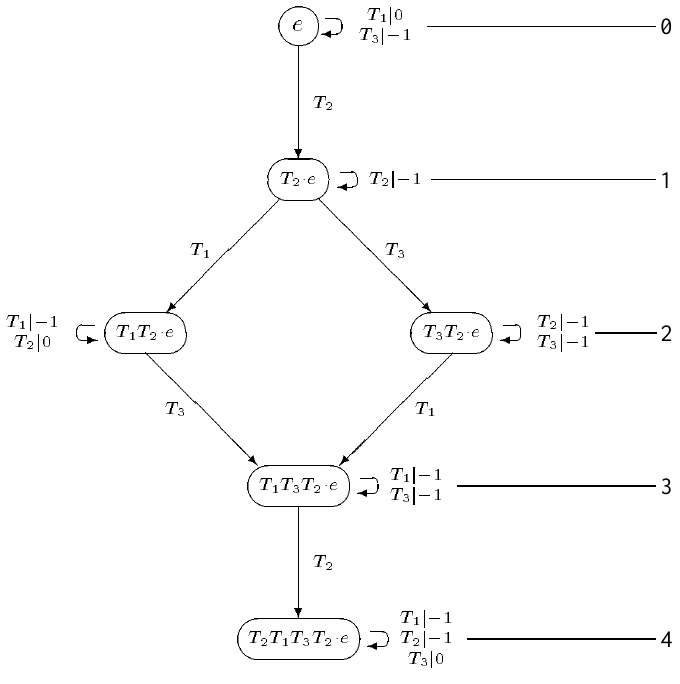
Fig. 1: The induced